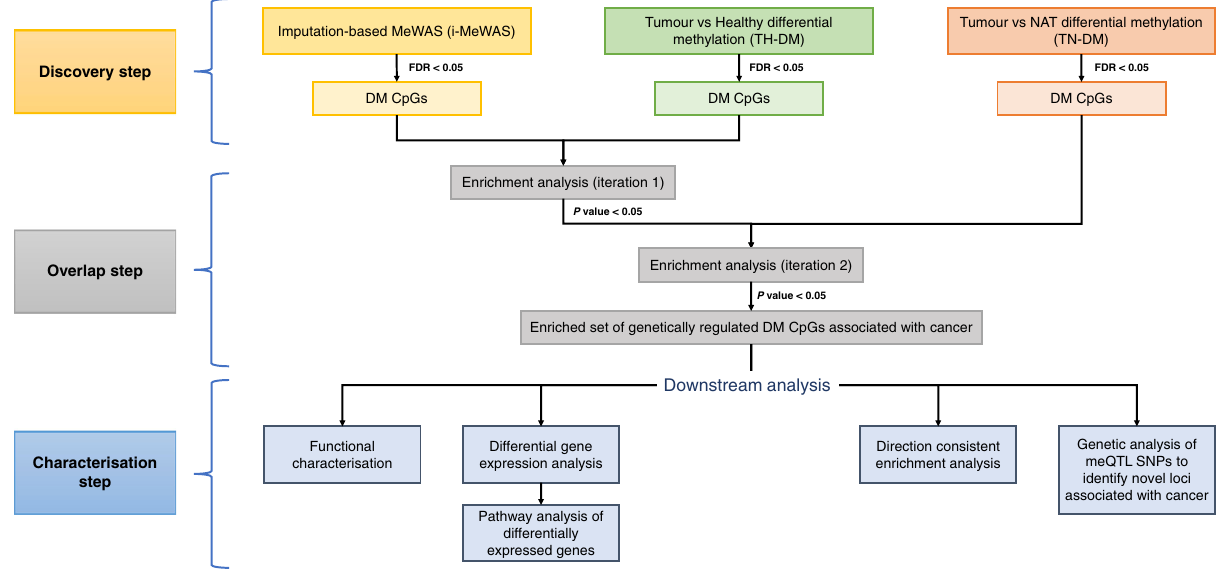
Fig. 1 Bioinformatics pipeline to identify cancer-associated genetically in fl uenced DNA methylation biomarkers (CpGs). The pipeline involves three steps including imputation-based and conventional methylome-wide association analyses using GWAS summary statistics and TCGA datasets, respectively, in the discovery step, enrichment testing and identi fi cation of an enriched set of cancer-associated CpGs in the overlap step, and lastly, functional characterisation of the CpGs, differential expression and pathway analysis of the genes associated to the CpGs, and genetic analyses in the characterisation step. CpGs cytosine-phosphate-guanine sites, DM differentially methylated, MeWAS methylome-wide association study, NAT histologically normal tissue adjacent to the